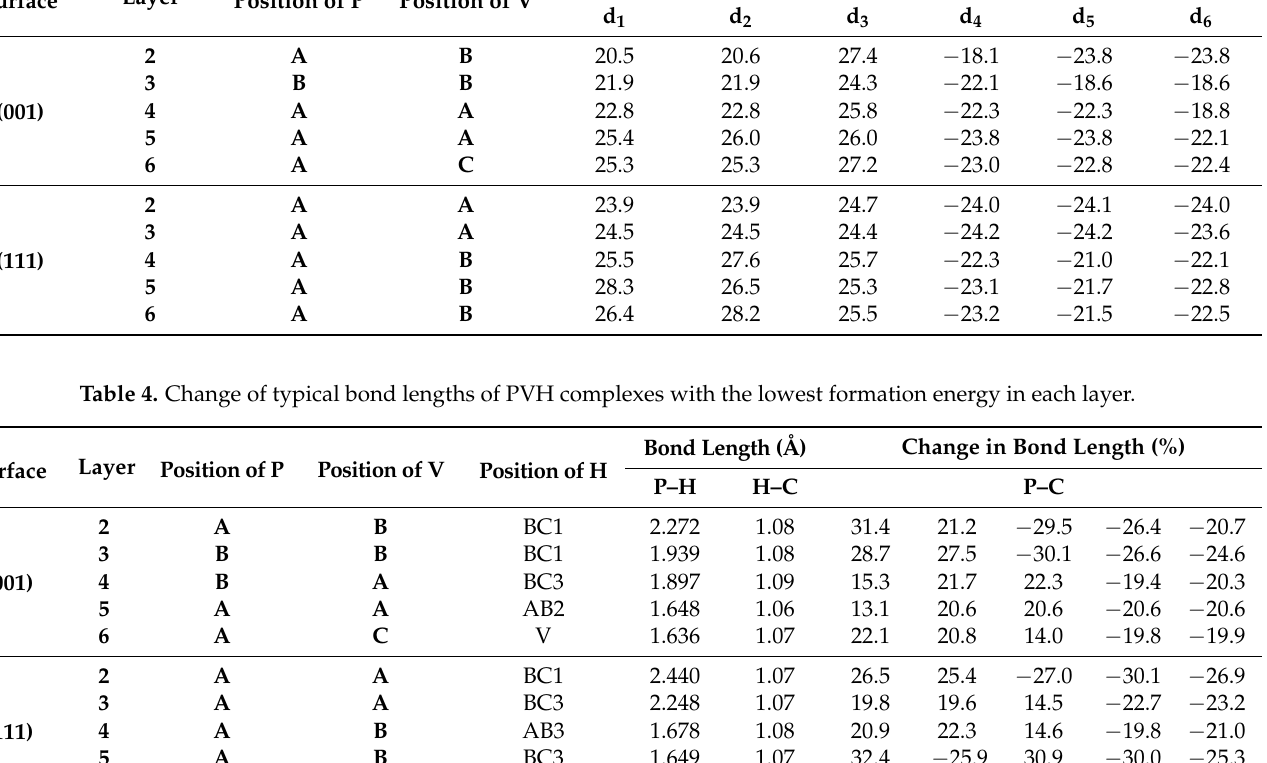
Table 3. Change of typical bond lengths of PV complexes with the lowest formation energy in each layer with the surrounding C atoms. (+) indicates an increase in the bond length compared with the non-doped surface and ( − ) indicates a decrease in the bond length compared with the non-doped surface. Surface Layer Position of P